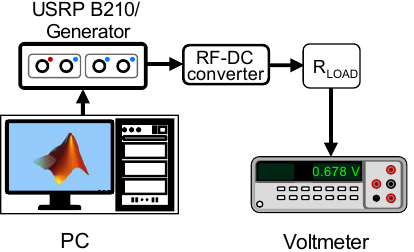
Fig. 3. Test setup for the RF-DC conversion measurements in wired testing mode.